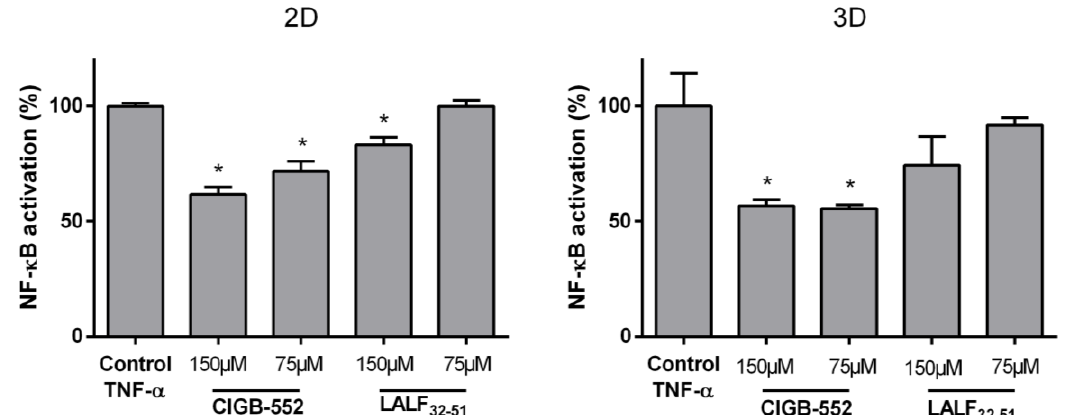
Figure 2. Evaluation of TNF- α -induced NF- κB transcription HT -29-NF- κB -hrGFP spheroids. Cells were seeded on non-adherent (3D) or adherent (2D) surfaces and cultured for four days. Cells were treated with the peptides and TNF- α for 24 h. GFP expression was assessed by flow cytometry considering 10,000 single cells for each sample. NF- κB activation was calculated considering GFP expression of the TNF- α -stimulated control as 100% activation and data were normalized to this 100% control. Data represented as the mean ± SD of technical triplicates of one representative experiment out of three. One-way ANOVA analysis (Dunnett’s post-test) were applied to compare the treated groups with the control, * p < 0.05.